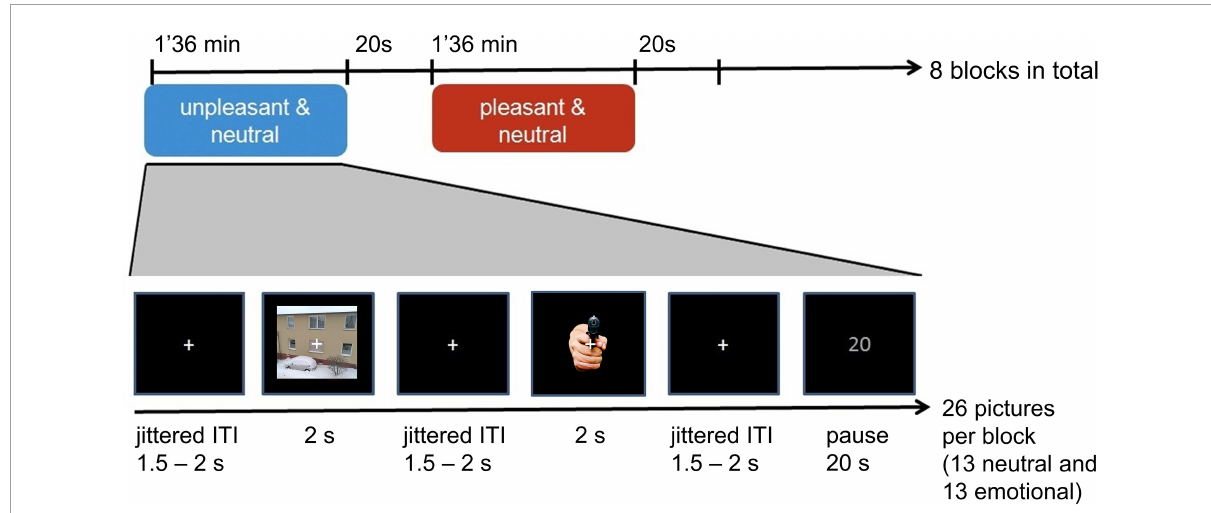
FIGURE1 Experimental paradigm. Passive viewing task during which participants were gazing at the fixation cross while perceiving the picture around the cross. Neutral pictures were presented among either pleasant or unpleasant